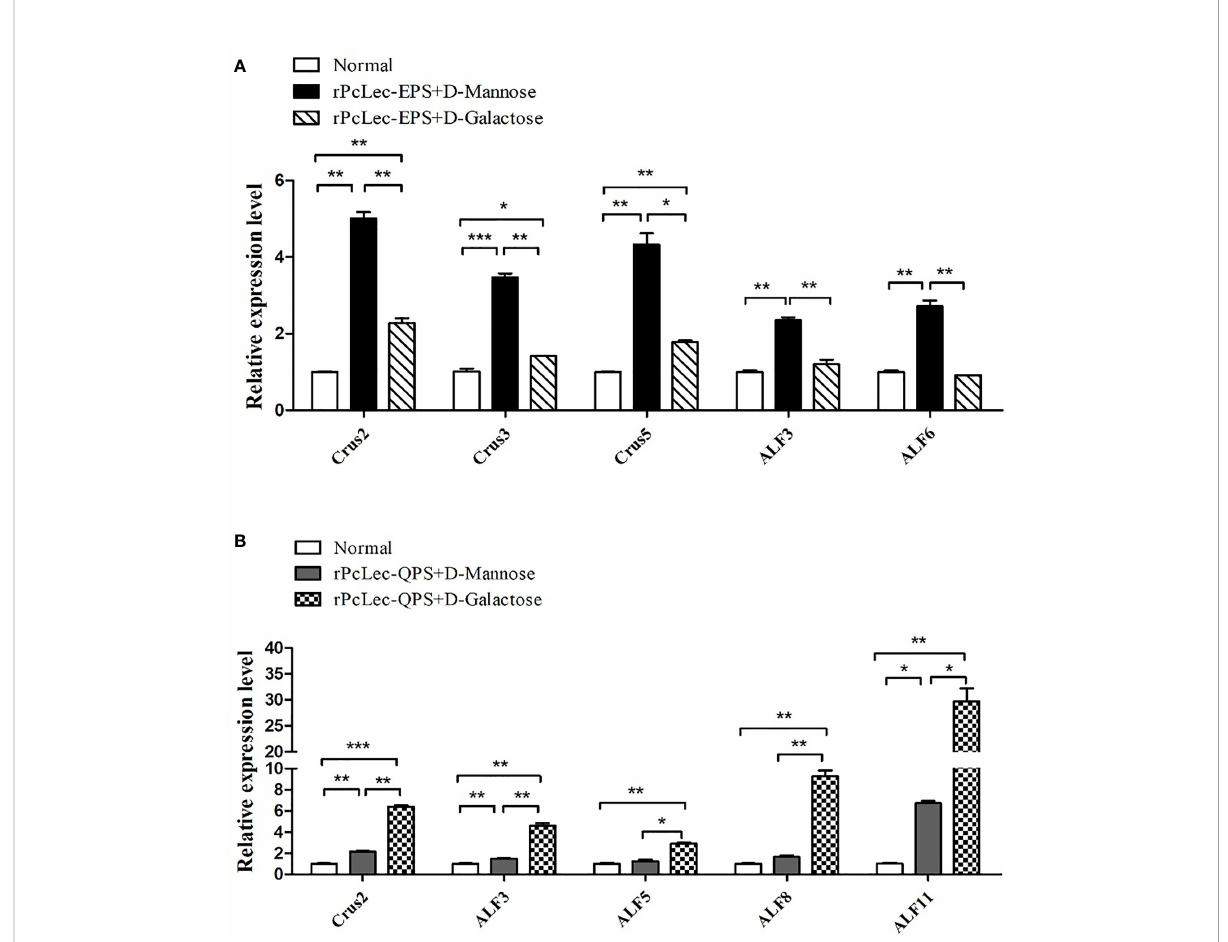
FIGURE 6 Analysis of AMPs expressions regulation by mixture of recombinant CTLs (rPcLec-EPS and rPcLec-QPS) and carbohydrates (D-Mannose and D- Galactose). (A) Expression levels of Crus2 , Crus3 , Crus5 , ALF3 , and ALF6 in the gills at 24 h after injection of rPcLec-EPS and carbohydrate (D- Mannose or D-Galactose) mixture were analyzed by RT-qPCR. (B) Transcription levels of Crus2 , ALF3 , ALF5 , ALF8 , and ALF11 in the gills at 24 h after injection of recombinant rPcLec-QPS and carbohydrate (D-Mannose or D-Galactose) mixture were analyzed by RT-qPCR. Each sample was composed of fi ve cray fi shes. Samples from untreated cray fi shes (normal) were collected as control. Data are presented as mean ± SD, N=5. Asterisks (* p < 0.05, ** p < 0.01, and *** p < 0.001) indicate that there are signi fi cant differences between two different experimental groups at the same time